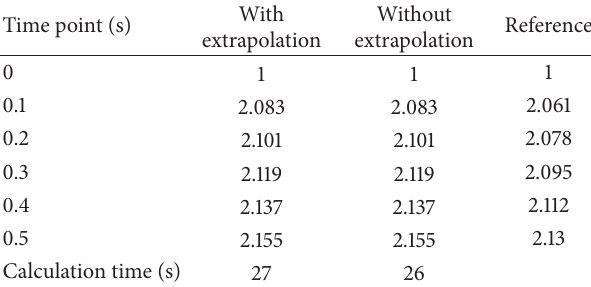
Table 12: Normalized power versus time with and without fission source extrapolation in TWIGL problem during ramp perturbation. With Time point (s)